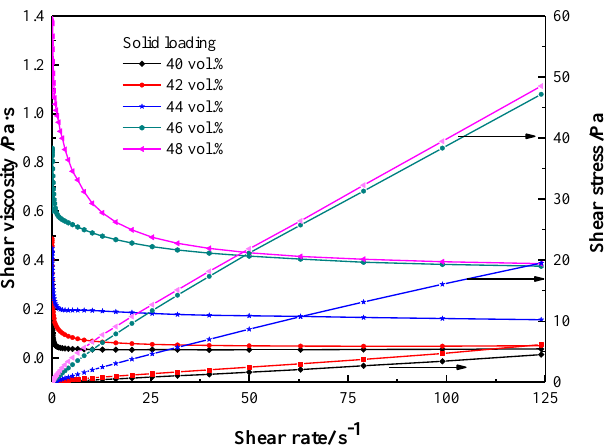
Figure 4. Effects of the solid loading on the rheological properties of the TiH 2 /Al slurries.